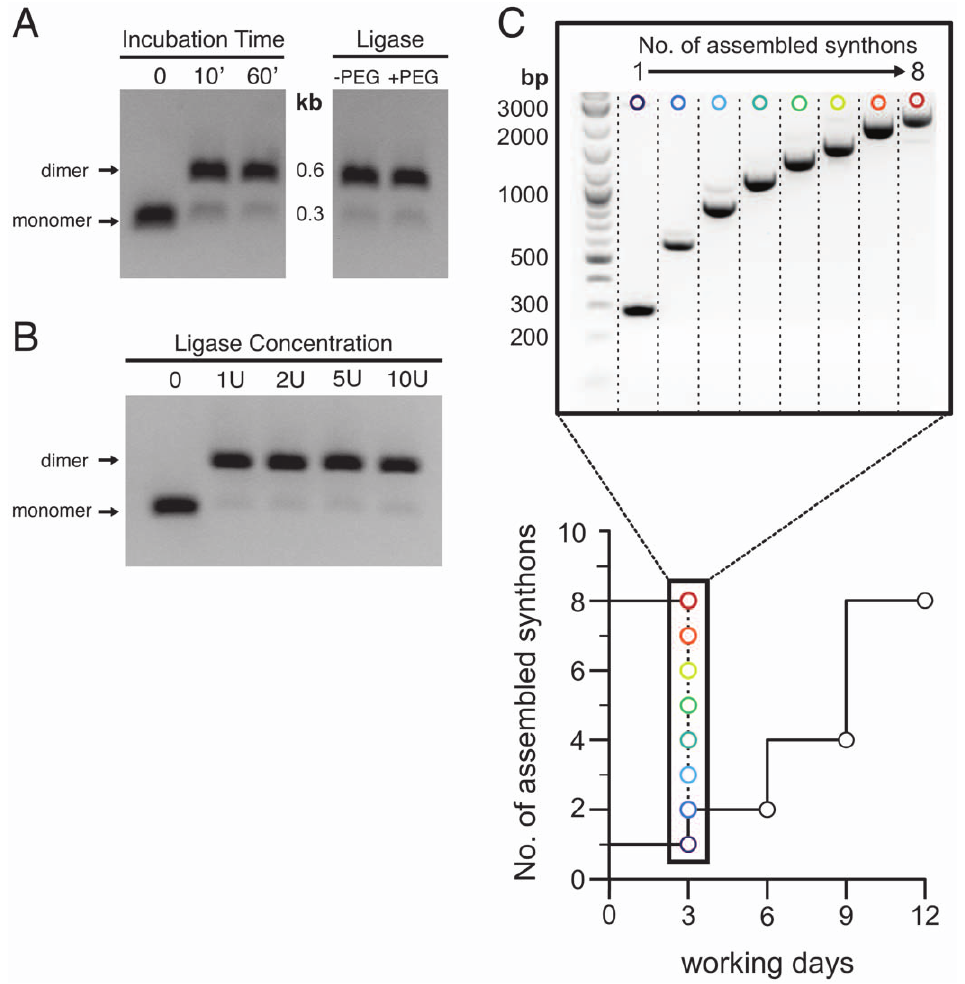
Figure 3. Efficient synthon assembly with split-and-pool reactions. (A) Equimolar amounts of BsaI or BsmBI deprotected 13 FNIII synthons were incubated with 1 unit of T4 ligase and product formation was assessed at different time points (left panel) or after 15 min in buffer conditions with and without 15% (w/v) PEG6000 (right panel). (B) No significant differences in assembly efficiency are observed after 15 9 incubation at ligase concentrations ranging from 1 to 10 units. (C) Performance of split-and-pool assembly in comparison to sequential approaches. Within one day the comprehensive series of ( 13 FNIII) 1 to ( 13 FNIII) 8 repeats can be assembled with the split-and-pool approach (spectrum circles) and ligated into the pShuttle vector. After a single cloning step expression plasmid is obtained on day 3. In comparison, sequential assembly with e.g. the BamHI/BglII system requires 12 days to obtain the ( 13 FNIII) 8 construct.